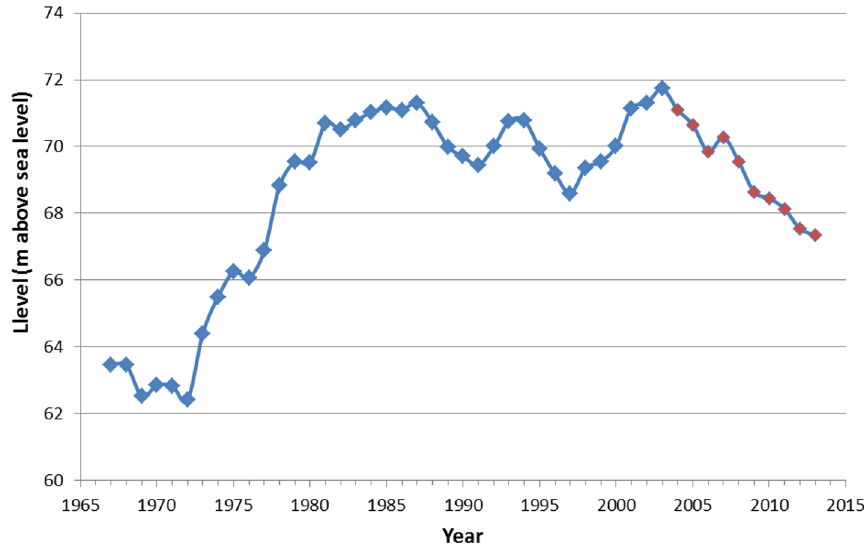
Fig 3. Water level of Mar Chiquita Lake in the 1967 – 2013 period. In red, years when dust storms were recorded. Data from the Mar Chiquita Field Station, PROMAR, Universidad Nacional de Córdoba,